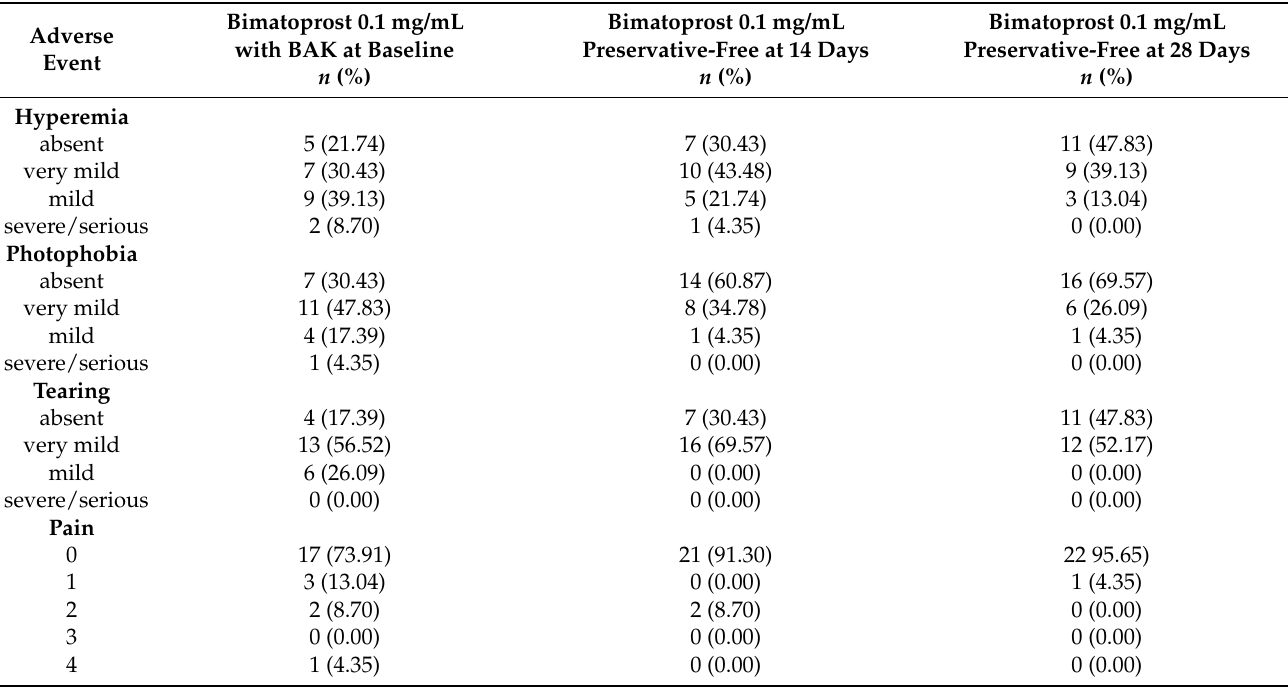
Table 3. Adverse event totals recorded between Bimatoprost 0.1 mg/mL with BAK at baseline